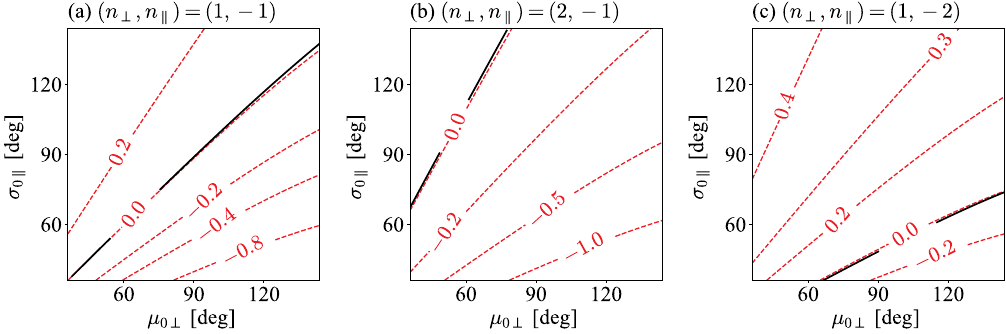
FIG. 12. Contour plots of Λ ð n ⊥ ; n k Þ in an equipartitioned case. The same initial beam conditions as considered in Fig. 4 are taken to calculate the Λ -value at each operating point with (a) ð n ⊥ ; n k ; n 0 Þ ¼ ð 1 ; − 1 ; 0 Þ , (b) ð n ⊥ ; n k ; n 0 Þ ¼ ð 2 ; − 1 ; 0 Þ , and (c) ð n ⊥ ; n k ; n 0 Þ ¼ ð 1 ; − 2 ; 0 Þ . A number on each contour line is the value of Λ ð n Þ divided by a normalization constant, i.e., the value of Λ ð 1 ; 1 Þ at the ⊥ ; n k operating point ð μ 0 ⊥ ; σ 0 k Þ ¼ ð 60 ° ; 60 ° Þ . Black solid lines are obtained from Eq. (6) with C 2 ¼ 0 . 7 or C 3 ¼ 0 . 8